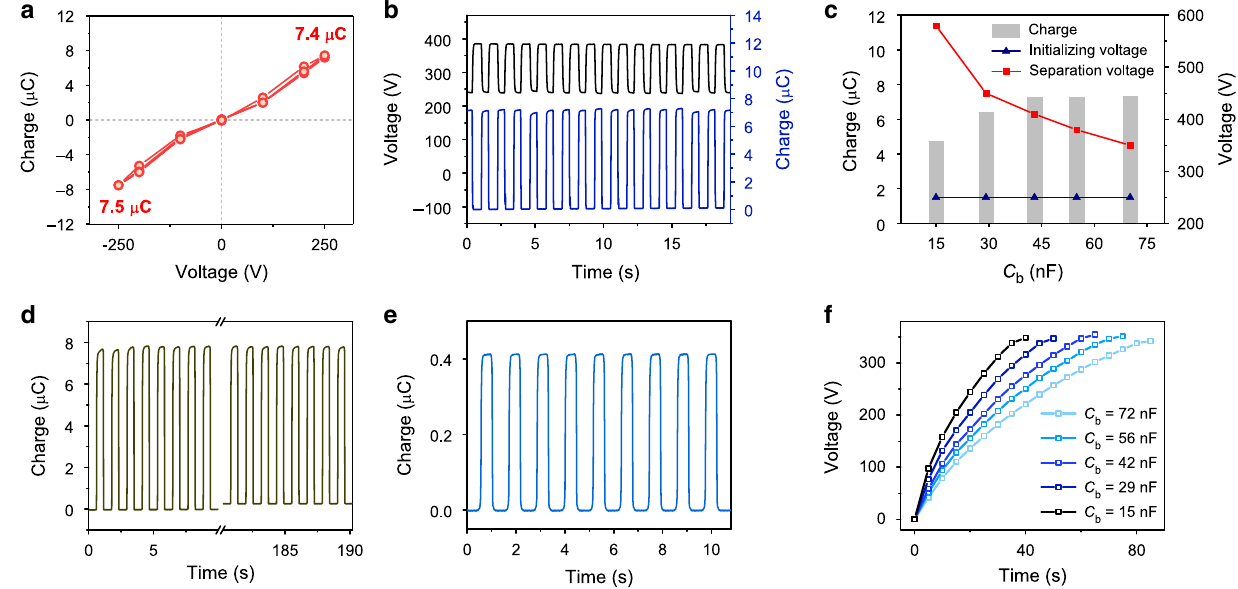
Fig. 2 Electrical characteristics of the main TENG and the pump TENG. a Shuttled charges of the main TENG in one domain under different initializing voltages. b Shuttled charges and voltage of the main TENG with an initializing voltage of 250V. c Shuttled charges and voltages of the main TENG with different buffer capacitors under an initializing voltage of 250V. d Decay of the shuttled charges under an initializing voltage of 250 V. e Short-circuit transferred charges of the pump TENG. f Voltage curves of the main TENG with different buffer capacitors charged by the pump TENG. Source data are provided as a Source Data fi